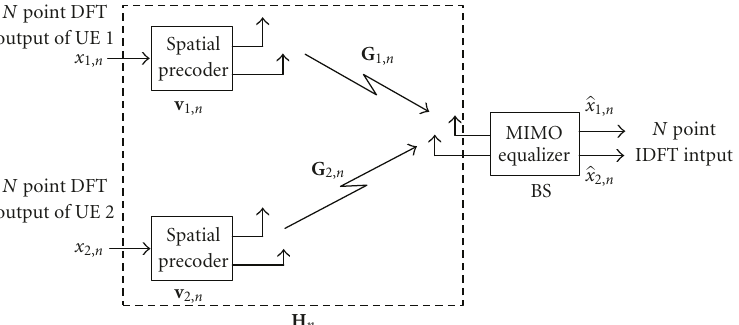
Figure 2: Spatial precoder for MIMO uplink with multiple transmit antennas at each UE and multiple antennas at the BS. The index n represents the n th allocated subcarrier in the